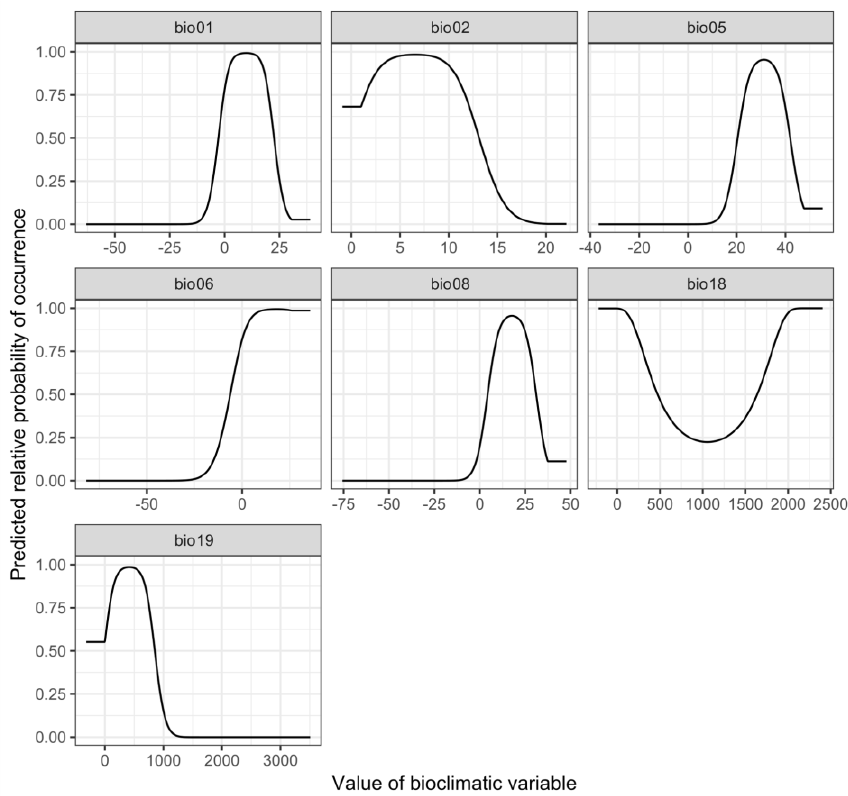
Figure 5. Response curves for seven selected environmental variables of Phytoseiulus